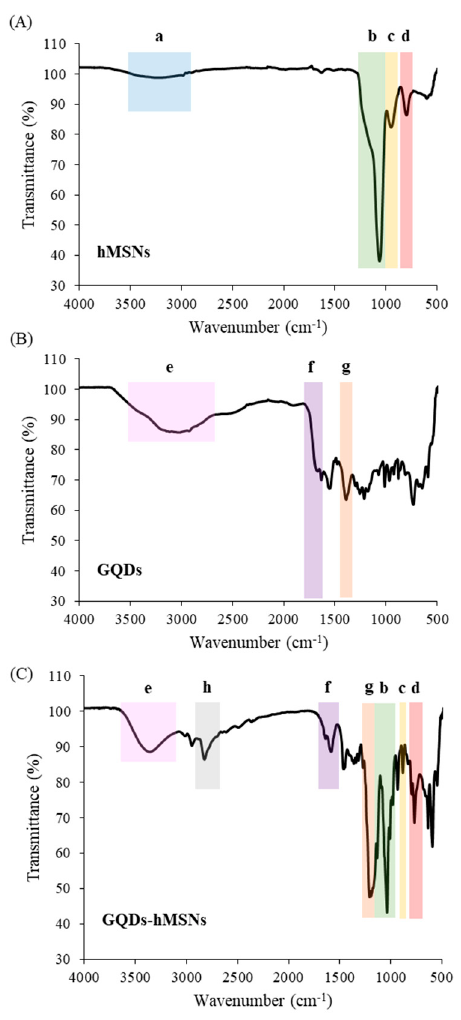
Figure 3. FT-IR spectra of hMSNs ( A ), GQDs ( B ), and GQDs-hMSNs ( C ). Peaks are ( a , blue) Si-O-H stretching, ( b , green) Si-O-Si bending, ( c , yellow) Si-OH vibration, ( d , red) Si-O vibration, ( e , pink) -OH, ( f , purple) C=O, ( g , orange) C-O/C-N, and ( h , gray)